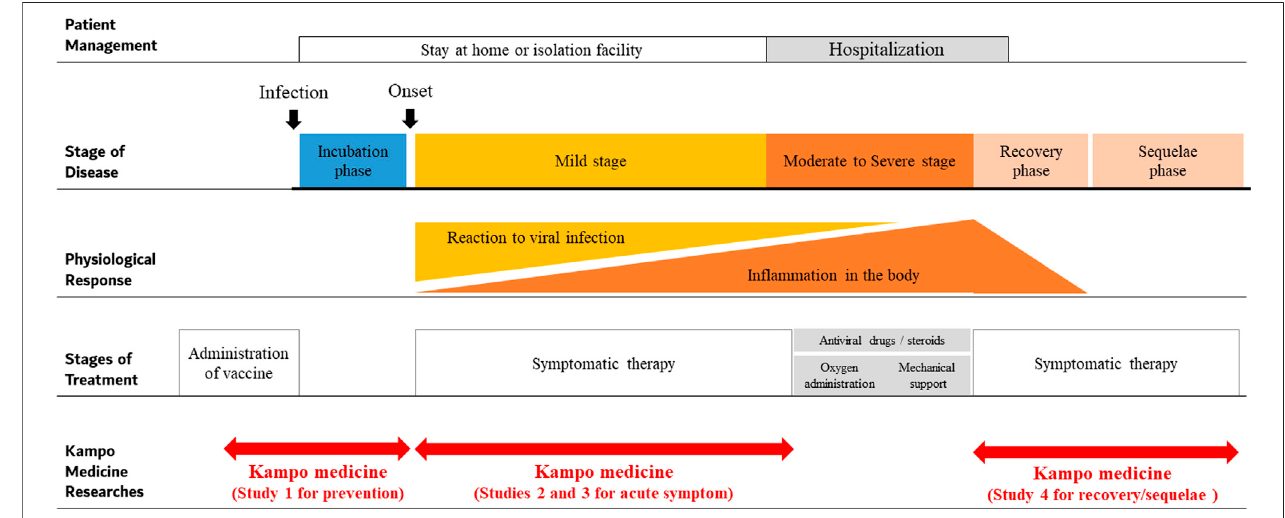
FIGURE 1 | Concept and clinical trials of Kampo medicine for